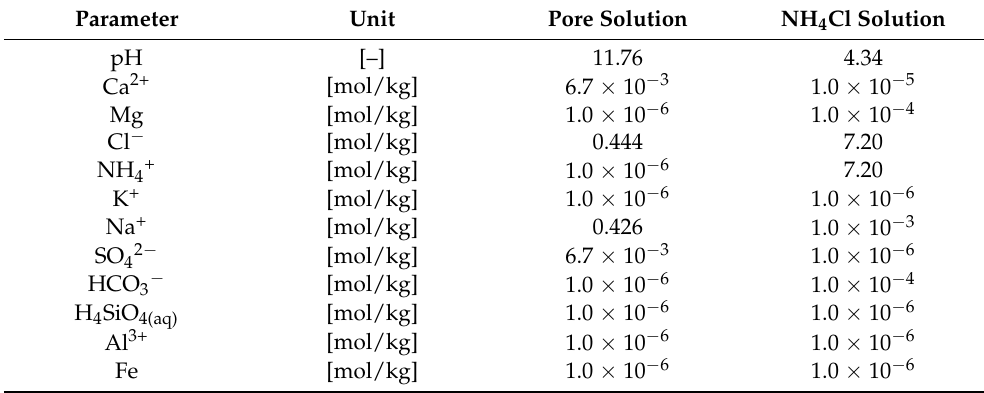
Table 4. Compositions of the pore solution and the NH 4 solution used in modeling.